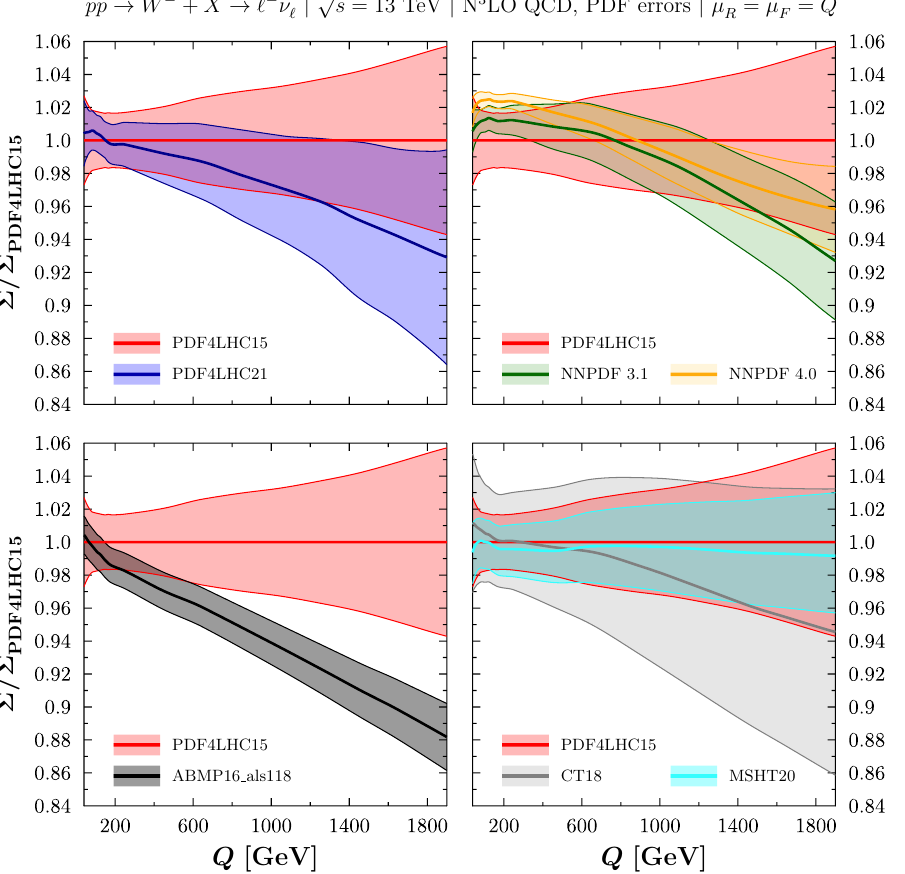
Figure 14 . Same as in figure 12, but for charged-current W − Drell-Yan differential cross section.